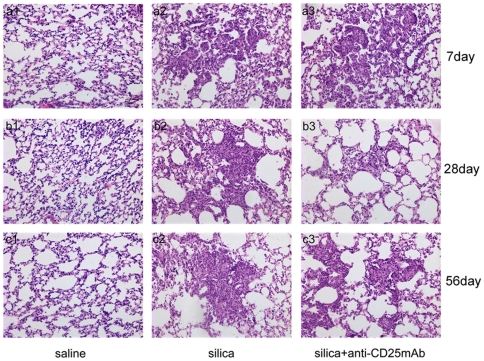
Histopathology changes in mouse lungs after instillation with HE staining (x200).a1-a3, day 7; b1-b3, day 28 and c1-c3, day 56. a1-c1, saline group; a2-c2, silica group; a3-c3,silica+anti-CD25mAb.